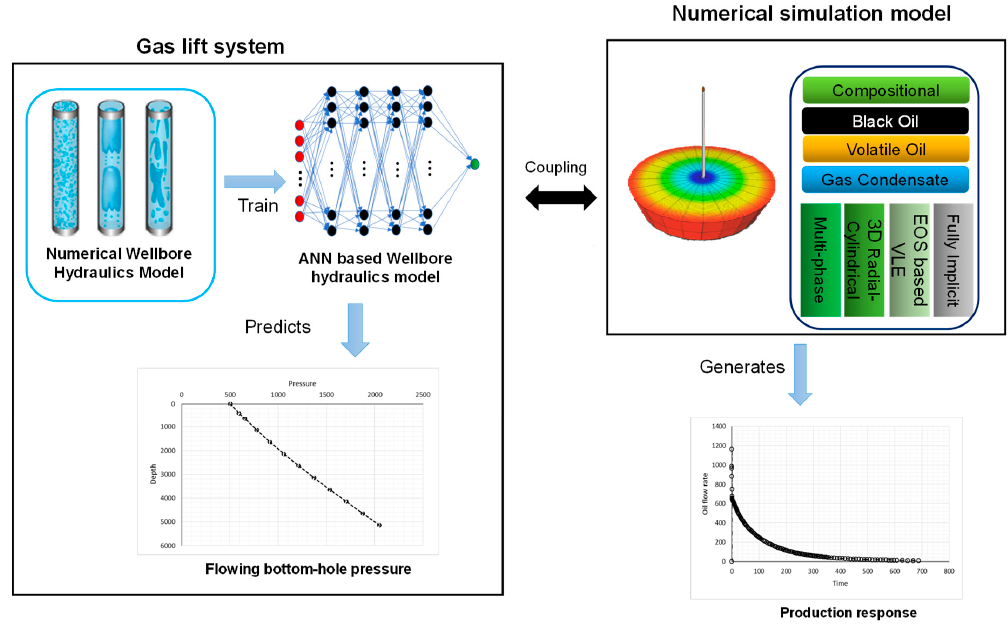
Figure 11. A coupled AI-numerical gas-lifting model.